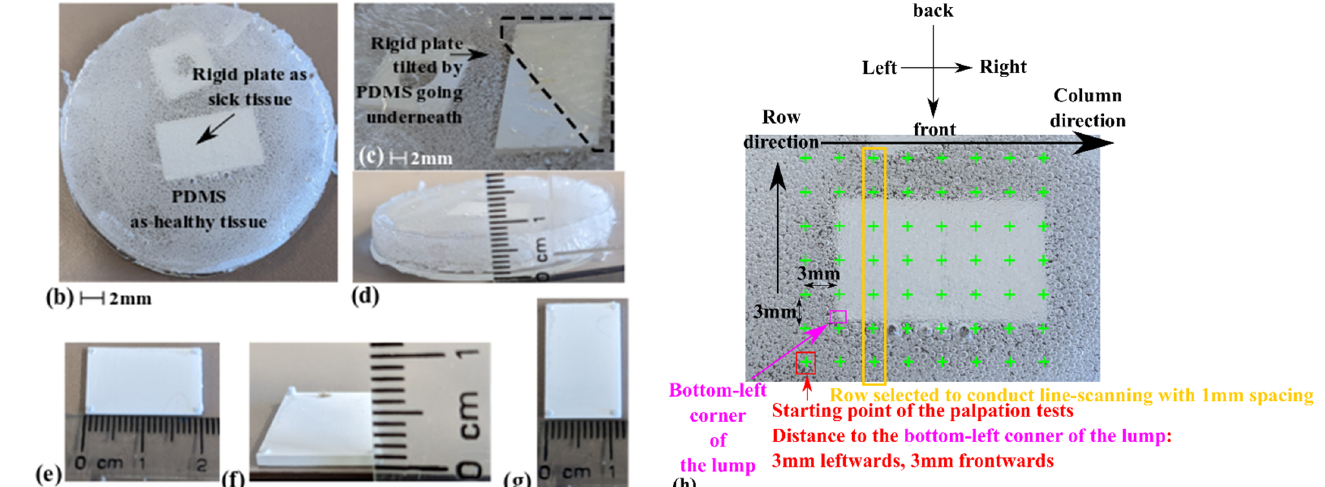
Figure 8. Method to test the piezoelectric tactile sensor effectiveness in palpation-based detection of buried rigid objects. ( a ) The flowchart of the method; ( b ) The top side of the self-made tissue phantom; ( c ) The bottom side of the phantom; ( d ) The thickness of the phantom; ( e – g ) The length, thickness, and width of the rigid plate as a hard tissue volume; ( h ) Map of the measurement locations.